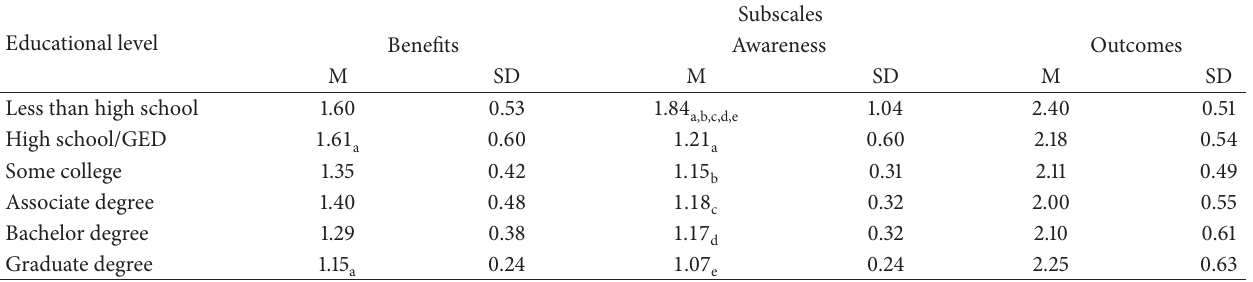
Table 5: One-way MANOVA—subscales measuring attitudes toward genetic testing by educational level of participants. Subscales Educational level Benefits